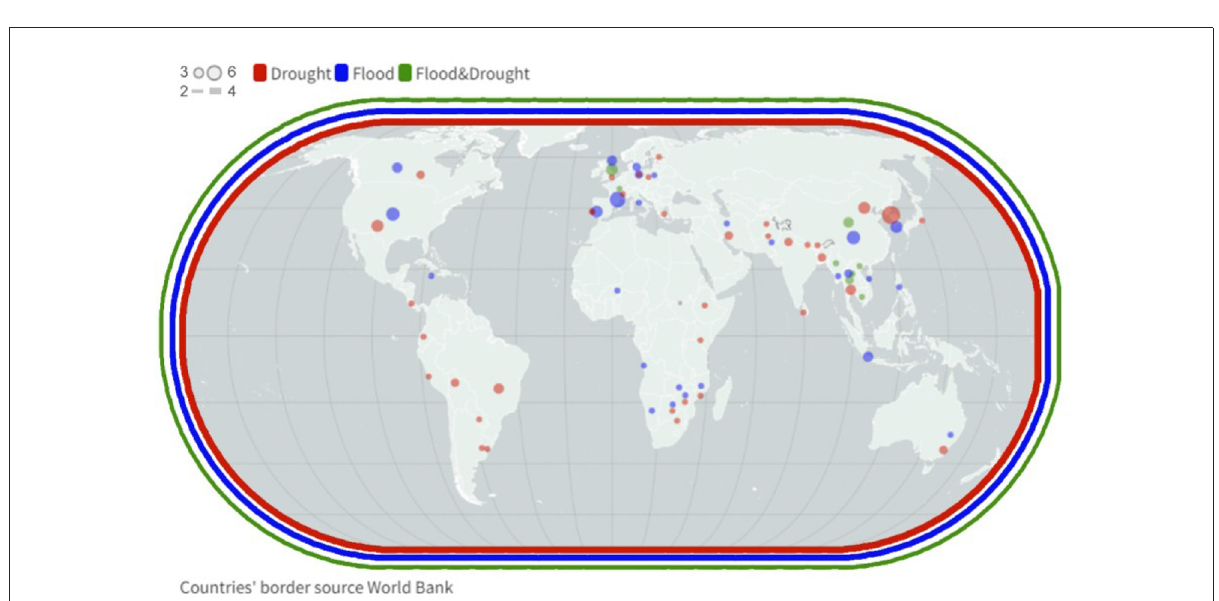
FIGURE2 Location of the analyzed research (dots for geographically-located works, circle for global works). The representation of the above map is available interactively at: https://public.flourish.studio/visualisation/8137783/. Details of papers presenting all of the above case studies are available interactively at: https://public.flourish.studio/visualisation/8168904/. The above public links were built using flourish studio visualization tool